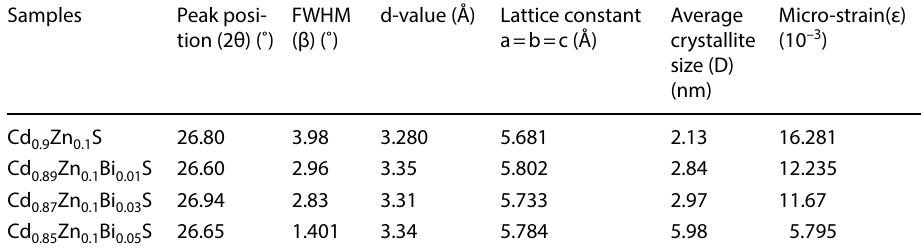
Fig. 2 a XRD peak intensity of Cd ‘ε’ and ‘D’ variations, d Cd